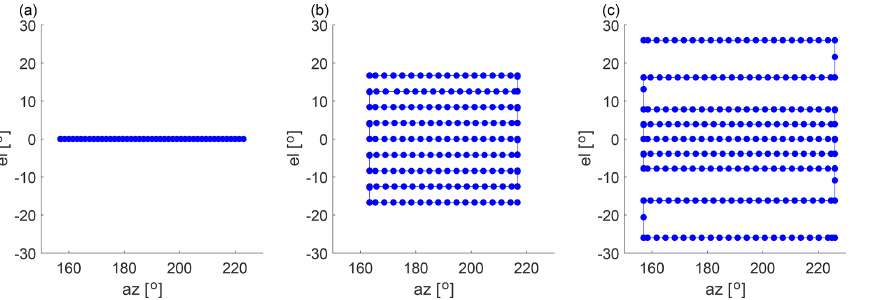
Figure 3. The scan pattern of the 2D (a) and the 3D scans with equally spaced elevation levels (b) and elevation levels with larger spacing at the top and bottom (c) . The path of the scanner is shown as a blue line, with measurement points indicated as blue